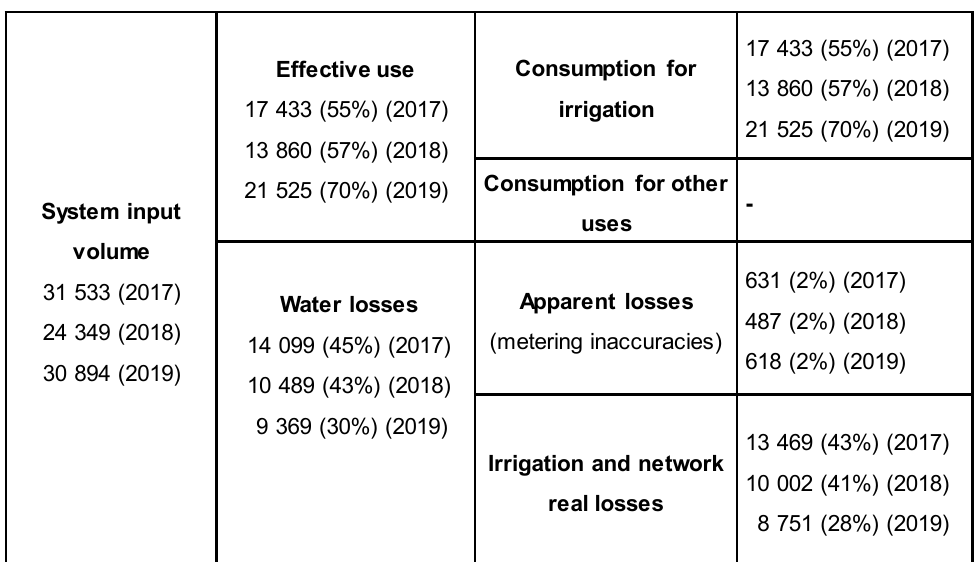
Figure 5. Water Balance for Case study 1 in 2017, 2018 and 2019 (m 3 /year). Annual variations in the system input volume and in the effective water used for the irrigation (i.e., LWR) are in agreement with observed variations of the precipitation and evapotranspiration. LWR in 2018 is the lowest within the analysed three-year period due to the highest precipitation (529 mm) in this year compared to 2017 (317 mm) and 2019 (229 mm). In 2019, due to lower precipitation, LWR increases but the system input volume does not increase proportionally, due to a more efficient water use and less water losses. This corresponds to the year 2019, when the smart irrigation system began to operate, and demonstrates that this smart system effectively reduces water losses.